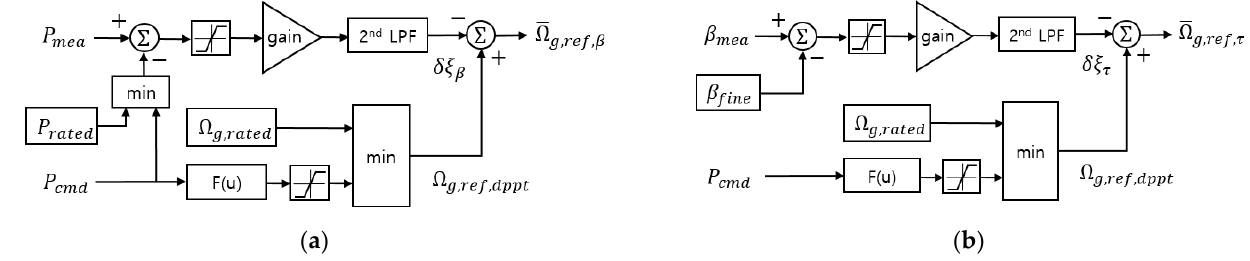
Figure 2. Block diagrams of RBC algorithms: ( a ) Pitch control loop; ( b ) Torque control